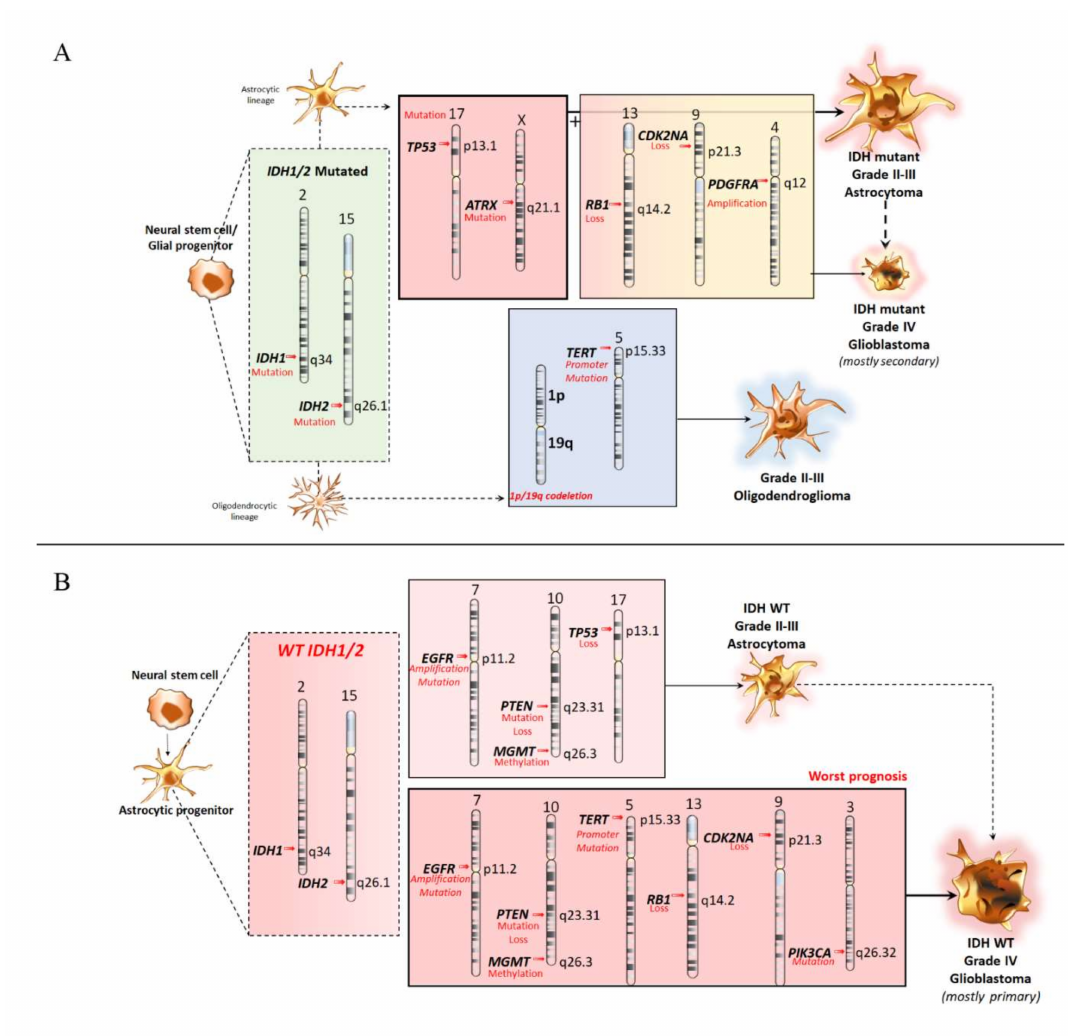
Figure 2. Genetic Biomarkers for IDH1 / 2 -mutated ( A ) and IDH1 / 2 -wild type ( B ) Astrocytomas and Oligodendrogliomas This cartoon roughly summarizes the main somatic gene mutations that are key in the classification of diffuse gliomas (DGs). ( A ). Biomarkers for astrocytomas / oligodendrogliomas featuring IDH1 / 2 mutations. Grade II-III astrocytomas are classified based on the occurrence of mutations within IDH1 / 2 along with TP53 (17p13.1) and ATRX ( α -thalassemia mental retardation X -linked, Xq21.1). Grade IV astrocytoma (glioblastoma) arise mostly secondarily to lower-grade astrocytoma and, to a lesser extent, primarily from additional mutations occurring within CDKN2A / B, RB1, and PDGFRA (platelet derived growth factor receptor alpha 4q12). The diagnosis of grade II-III oligodendroglioma requires the presence of a 1p / 19q codeletion and / or TERT promoter mutation besides IDH1 / 2 mutation. ( B ). Biomarkers for astrocytomas in the absence of IDH1 / 2 mutations. Intheabsenceofmutationswithin IDH1 / IDH2 genes(2q34and15q26.1, respectively), theclassification of grade II–III and / or grade IV astrocytoma (mostly primary glioblastoma) is based on frequently occurring somatic mutations within the following genes: PIK3CA (phosphatidylinositol-4,5-bisphosphate 3-kinase catalytic subunitalpha,3q26.32); TERT (telomerasereversetranscriptase,5p15.33); EGFR (epidermalgrowthfactorreceptor, 7p11.2); RB1 (retinoblastoma ranscriptional orepressor 1, 13q14.2); PTEN (phosphatase and tensin homolog 10q23.31); CDKN2A / B (cyclin-dependent kinase inhibitor 2A / B, 9p21.3); TP53 (tumor protein p53, 17 p13.1); MGMT (O6-alkylguanine DNA alkyltransferase, 10q26.3) methylation status may serve as a predictive biomarker of chemotherapeutic